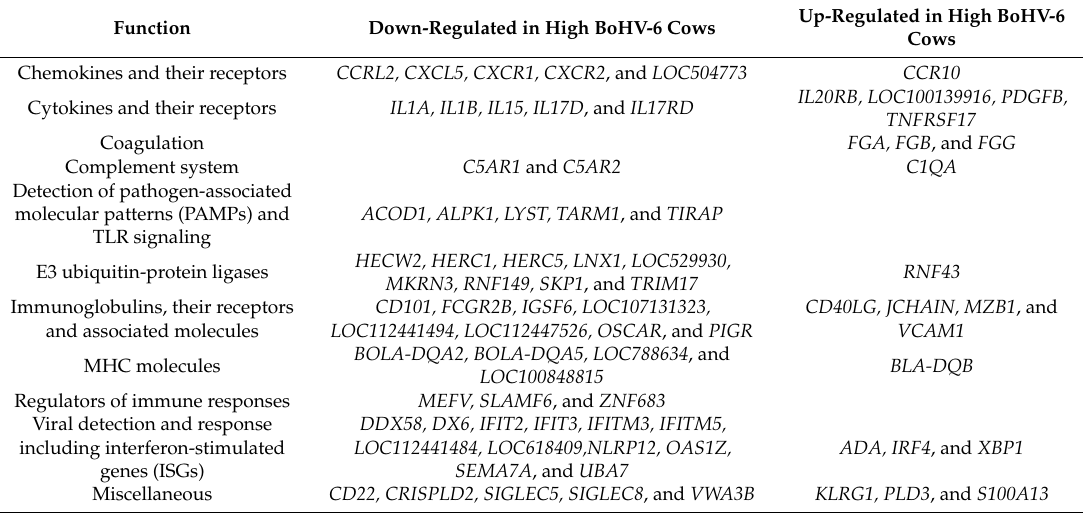
Table 7. Summary of main functions of DEGs identified as having a role in immune responses between cows with high ( > 200) and low (1–200) BoHV-6